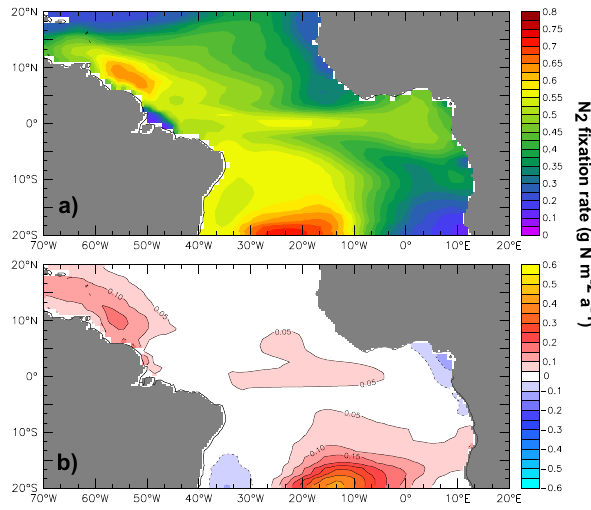
Fig. 6. Mean N-fixation rates in gNm − 2 a − 1 (average 1998–2005): (a) the TODAY scenario, (b) Difference between the TODAY and NO_RIVER